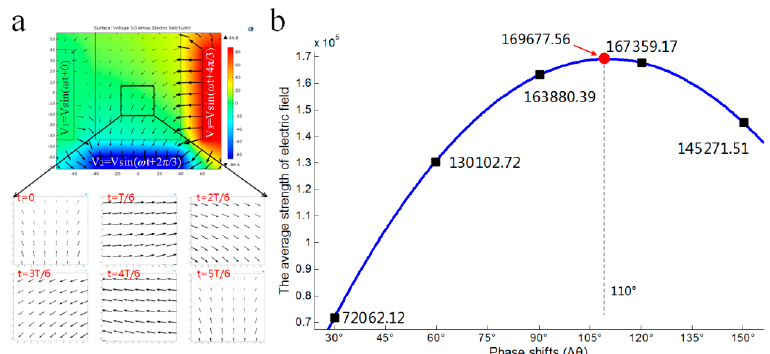
Figure 7. The electric field distribution of rotation about the X -axis. ( a ) The electric field distribution of the electrode chamber with one bottom electrode. ( b ) The average strength of the electrical field of one period within the 10-µm-square region at the center of the chamber.